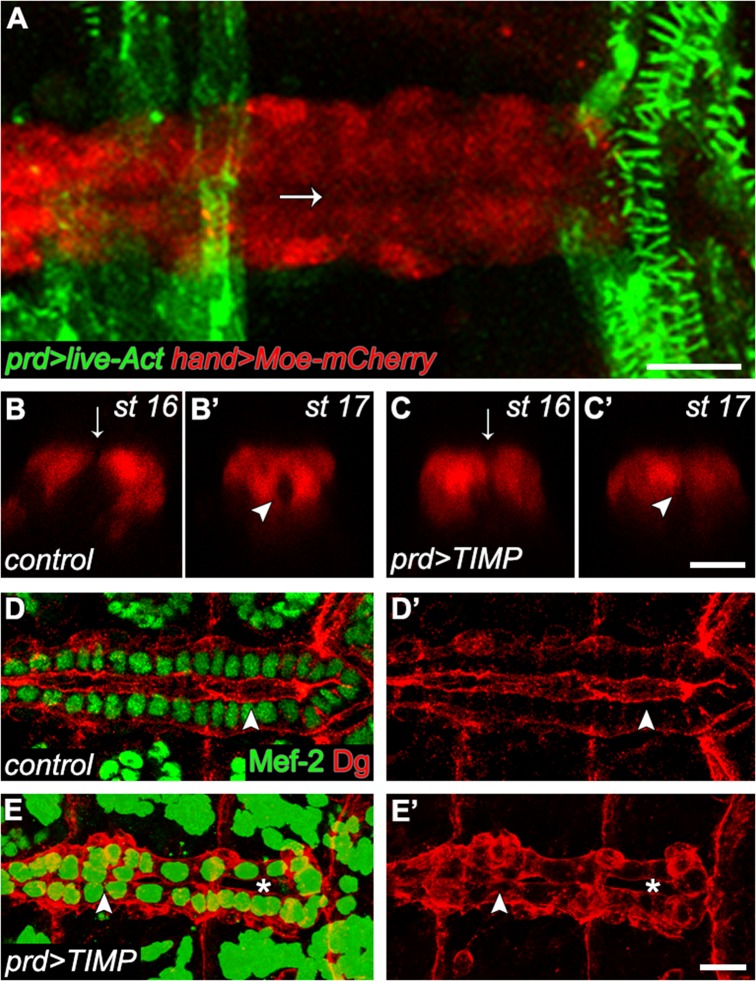
Inhibition of MMPs by ectopic expression of TIMP in the ectoderm disrupts heart lumen formation.(A) prd-GAL4 expression is reported by UAS-live-Actin-GFP (green) and CBs are expressing Moesin-mCherry under the control of hand promoter. Arrow indicates the CB midline. (B-C’) Cross sectional images were taken through the non-ostial cells under the non-paired expressing ectoderm. (B-B’) In stage 16 control embryos, CBs extend protrusions (arrow) towards the contralateral partner cells and by stage 17 form an enclosed lumen (arrowhead). (C-C’) When TIMP is expressed in paired expressing ectodermal stripes, apical protrusions (arrow) do not form and lumen formation does not occur (arrowhead). (D-D’) In stage 17 control embryos, Dg localises to the apical luminal domain of CBs (arrow). (E-E’) In embryos expressing TIMP ectopically, accumulation of Dg is observed around the CBs and a medial lumen fails to form (arrow). Gaps between contralateral CBs are also observed (asterisk). Scales—10 μm.